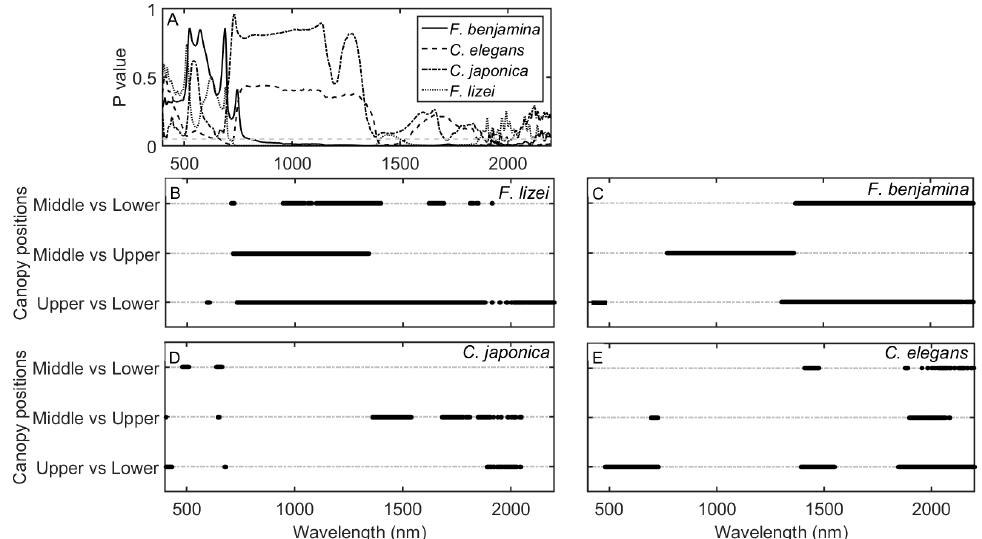
Figure 5. Species- specific ANOVA test for mean leaf spectral reflectance at three canopy positions ( A ) and pairwise t-test of mean leaf spectral reflectance at three canopy positions for F. lizei ( B ), F. benjamina ( C ), C. japonica ( D ) and C. elegans ( E ). Dark circles indicate spectral wavebands that were significantly different ( P ≤ 0.05) for each pairwise comparison.